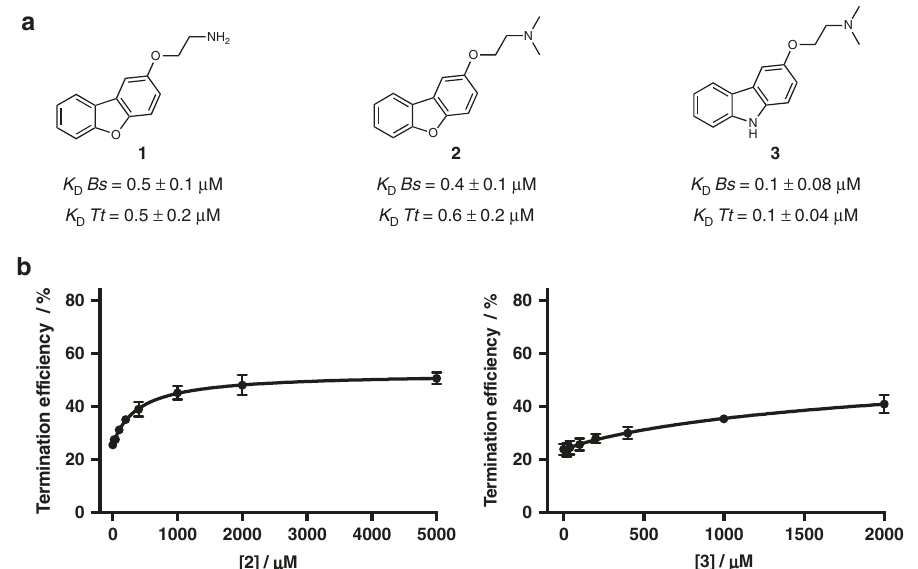
Fig. 7 Evaluation of modi fi ed analogs of 2 and 3 . a Apparent K D values for 1 – 3 as determined by fl uorescence intensity assays with 5 ′ -Cy5- Bs PreQ 1 -RS and 5 ′ -AlexaFluor 647- Tt PreQ 1 -RS RNA. Values are the mean ± s.d. (error bars) of three replicate measurements. b Quanti fi cation of termination ef fi ciency of increasing concentrations of 2 (left) and 3 (right) in transcription termination assays of a DNA template containing the Ss PreQ 1 riboswitch. Error bars indicate the standard deviation determined from three independent measurements. Source data are provided as a Source Data fi le. Gel images are provided in the Supplementary